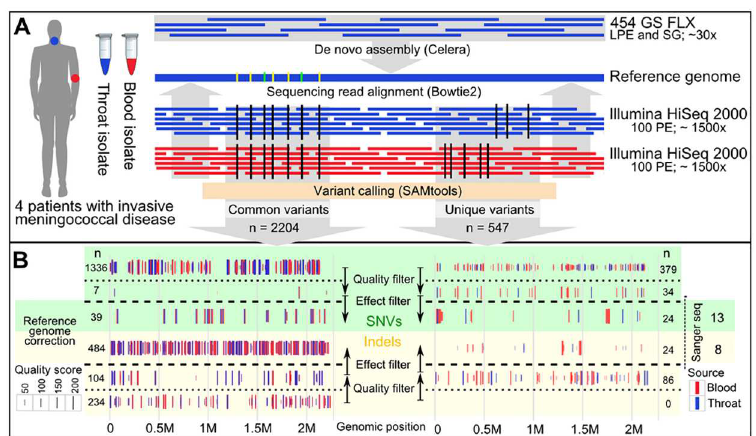
Fig 3. Comparative genome sequencing of meningococcal throat-blood isolate pairs from four IMD patients. (A) Referencegenomeassemblyfor the throat isolateof each patient was performed from large paired-end (LPE) libraries and whole-genome shotgun (SG) librariesproducedusing the NGS platform 454 Genome SequencerFLX (GS FLX). For throat and blood isolates 100 base pair paired-end(PE) libraries were producedusing the Illumina HiSeq 2000 next generation sequencing platform. (B) Commonand unique variants are displayedby vertical lines accordingto their genomicposition separated in different panels for singlenucleotidevariants (SNVs) and short insertionsand deletions(Indels). Colors indicatethe source of the variant (blue: throat; red: blood). The line height indicatesthe variant quality score assignedby the variant